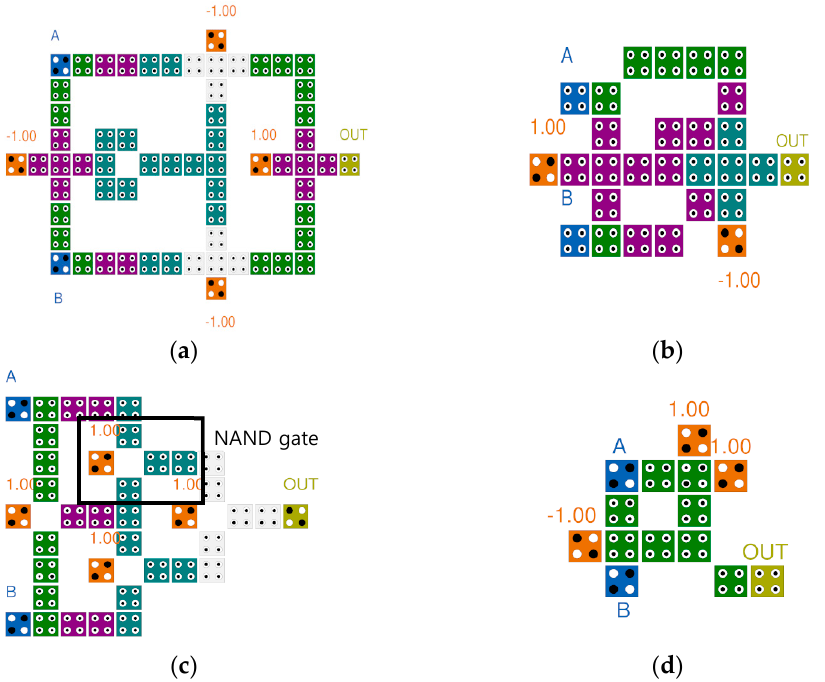
Figure 6. Conventional QCA XOR gates: ( a ) M. Mustafa et al.’s [11]; ( b ) M. B. Khosroshahy et al.’s [12]; ( c ) M. Poorhosseini et al.’s [13]; ( d ) A. M. Chabi et al.’s [14].